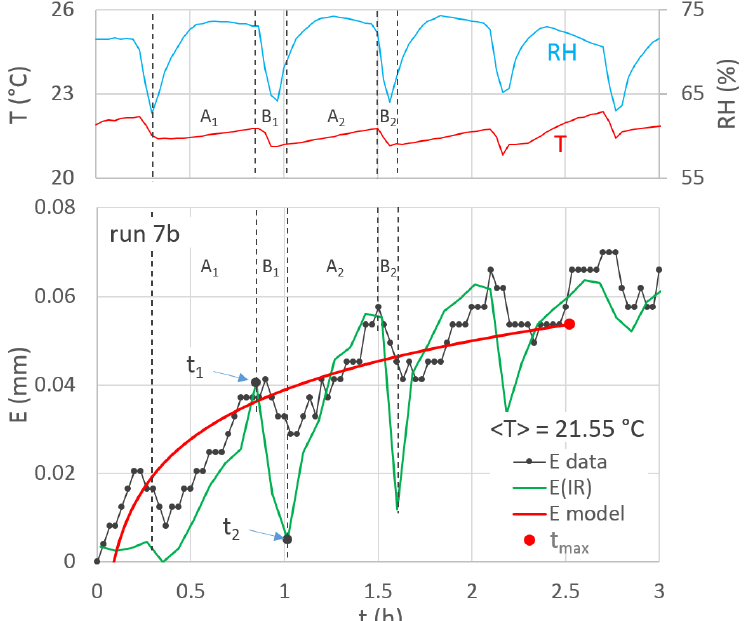
Figure 8. For run 7b, comparison between the temporal variation of the evaporation depth obtained by the experimental data with that obtained by the semi-log relationship (Equation (6)), and with that determined using IR images, E (IR), Equation (19). The time t 1 and t 2 , corresponding to Figure 9, for which water condensation occurred on the leaves, are indicated.